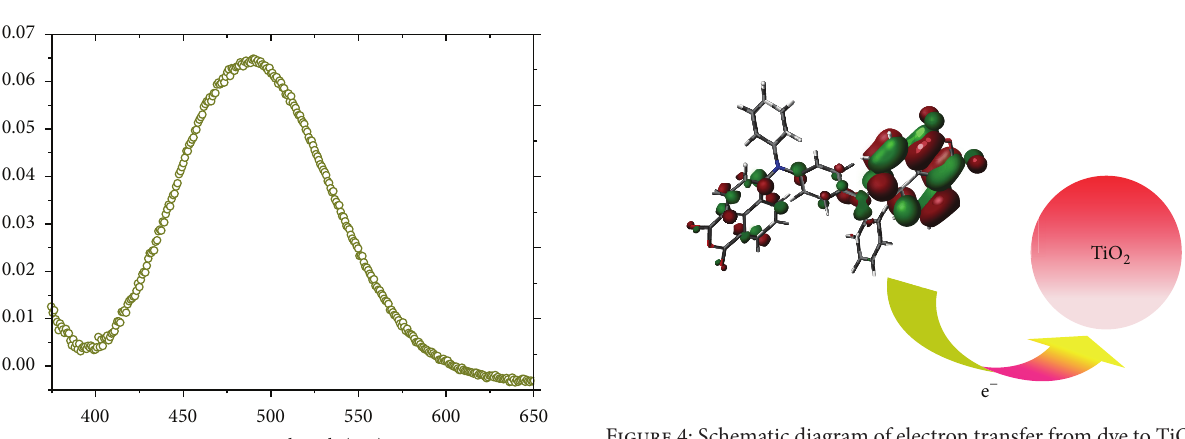
Figure 4: Schematic diagram of electron transfer from dye to TiO 2 .